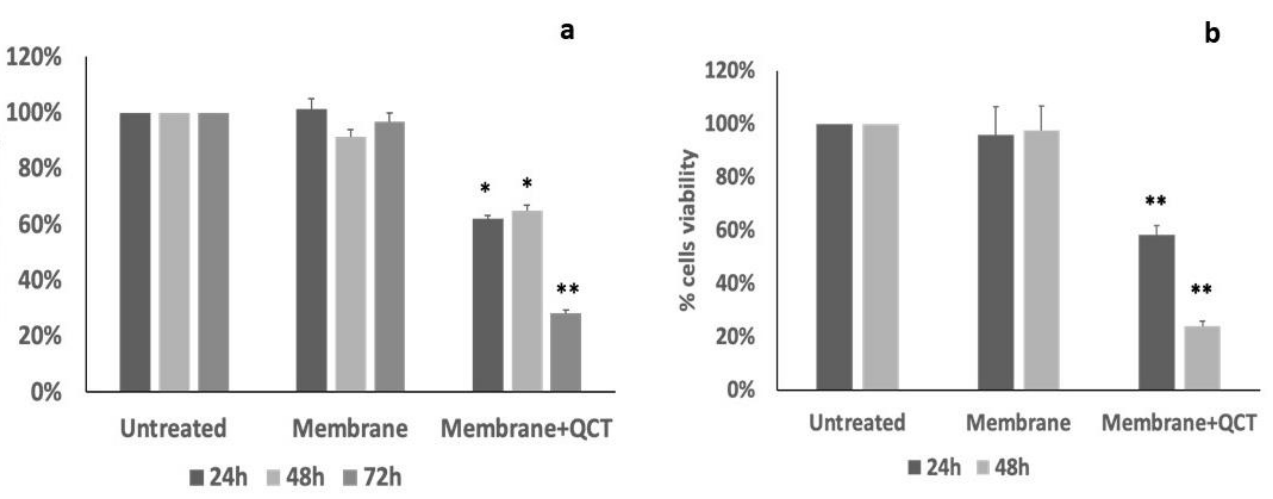
Figure 10. Cell viability assay. ( a ) MTT assay on KG1 cells after 24 h, 48 h and 72 h of treatment with membranes loaded with quercetin (direct contact); as negative control, not loaded membranes were used. ( b ) MTT assay on MRC5 cells after 24 h and 48 h of treatment with the conditioned medium, i.e., medium incubated for 24 h with membranes loaded with quercetin; as negative control, medium conditioned with non-loaded membrane was used. Data are reported are means ± standard errors of three independent experiments, each in triplicate and are expressed as the percentage of residual cell viability relative to the viability of untreated cells; * p < 0.05 and ** p < 0.01 versus untreated cells.